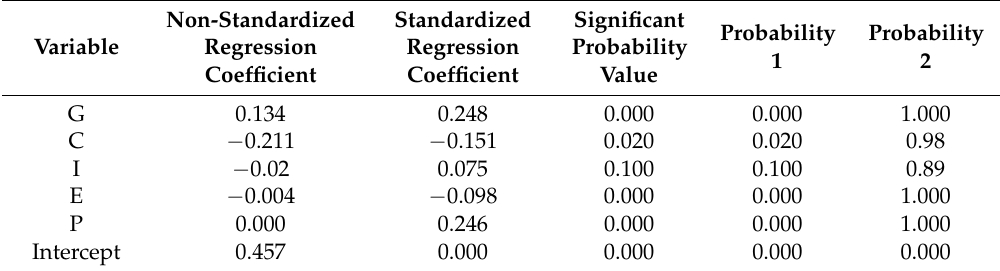
Table 3. Quadratic assignment procedure (QAP) regression analysis